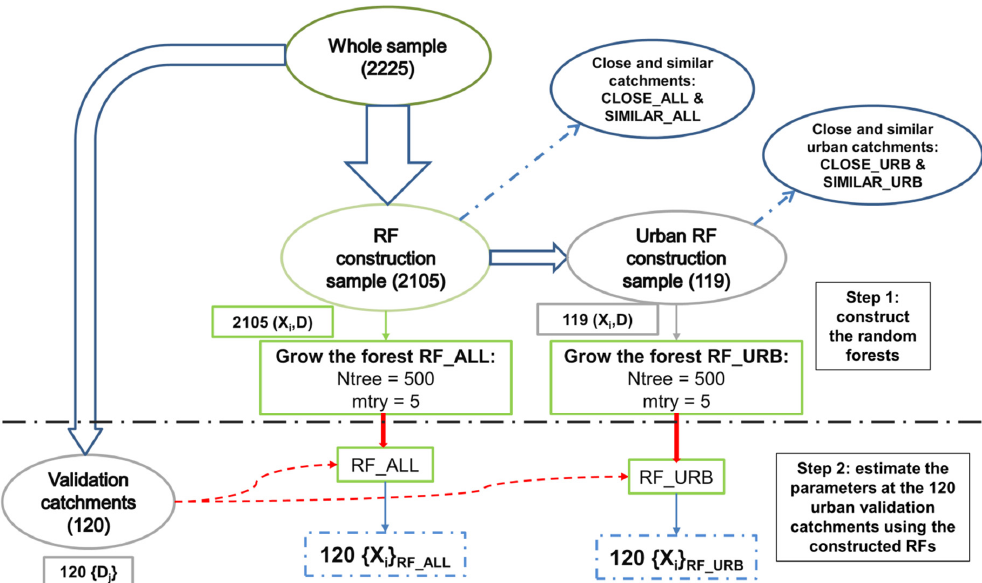
Figure 4. Random forest (RF) construction using the 2105 rural and urban catchments. Validation is carried on the remaining set of 120 urban catchments (i.e., with CPD ≥ 20%). During the process of RF growing, we considered the IncMSE (%) metric to evaluate each descriptor importance in the RF-established relationships [43]. For a descriptor j (in our case j is between 1 and 15), the values were randomly permuted for the OOB data and a corresponding RF MSE j was determined. If MSE 0 is the MSE of the RF computed during the construction, i.e., with non-permuted values for the OOB data, then IncMSE represents the difference between MSE 0 and MSE j , after being computed and then scaled by the standard deviation of the differences over the trees. The greater the IncMSE, the more important the predictor variable.